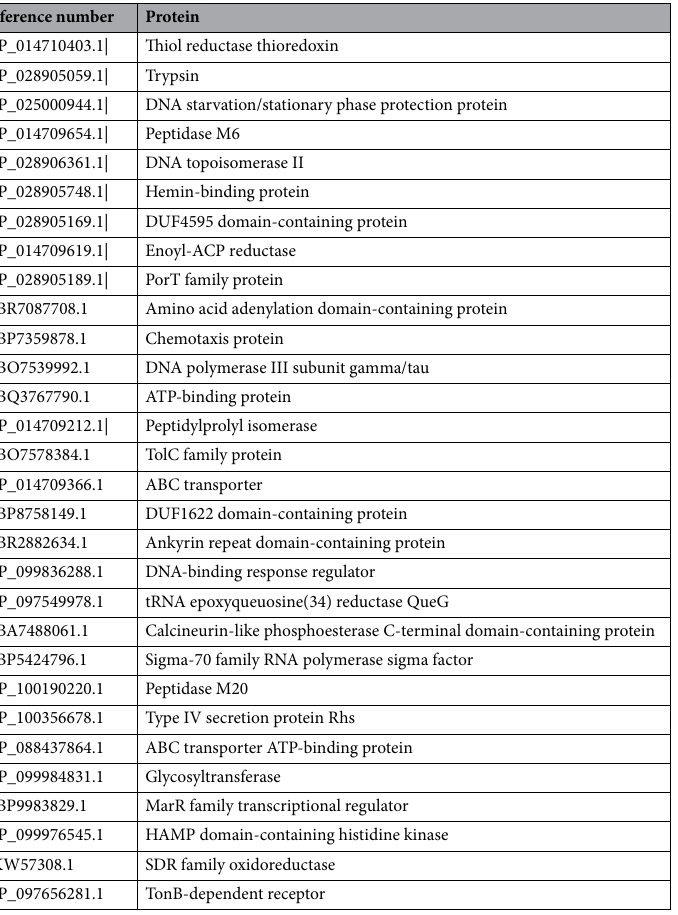
Table 2. Proteins with predicted virulence properties from P. intermedia planktonic